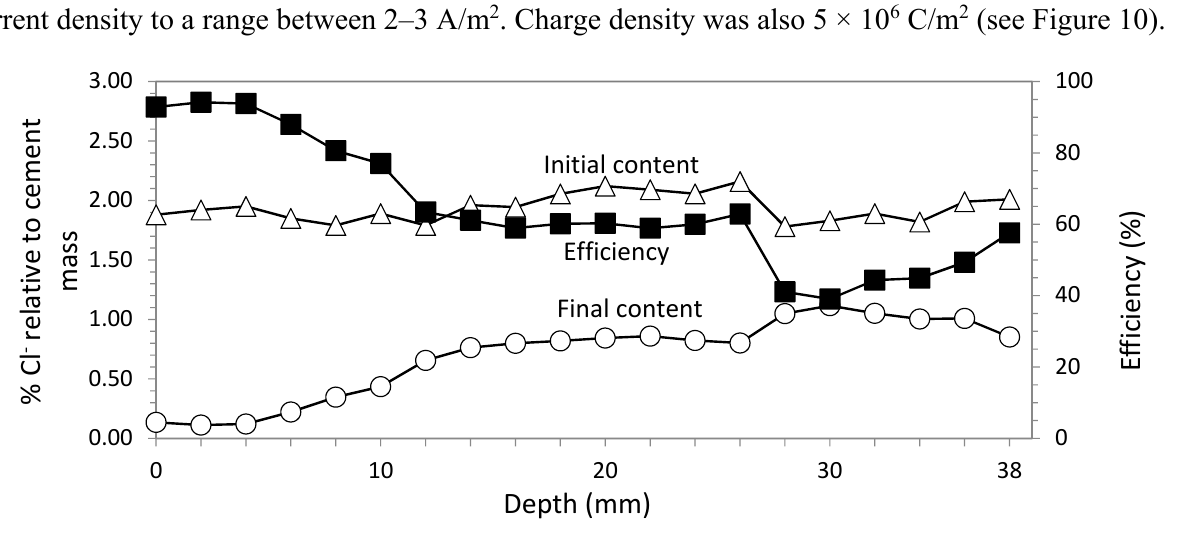
Figure 10. Study 5. Rectangular section specimens. ECE with GCP based anodic